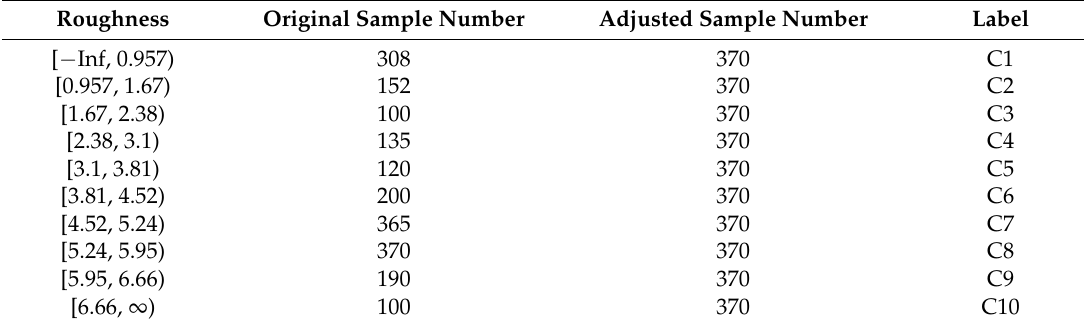
Table 3. Description of the surface roughness condition.